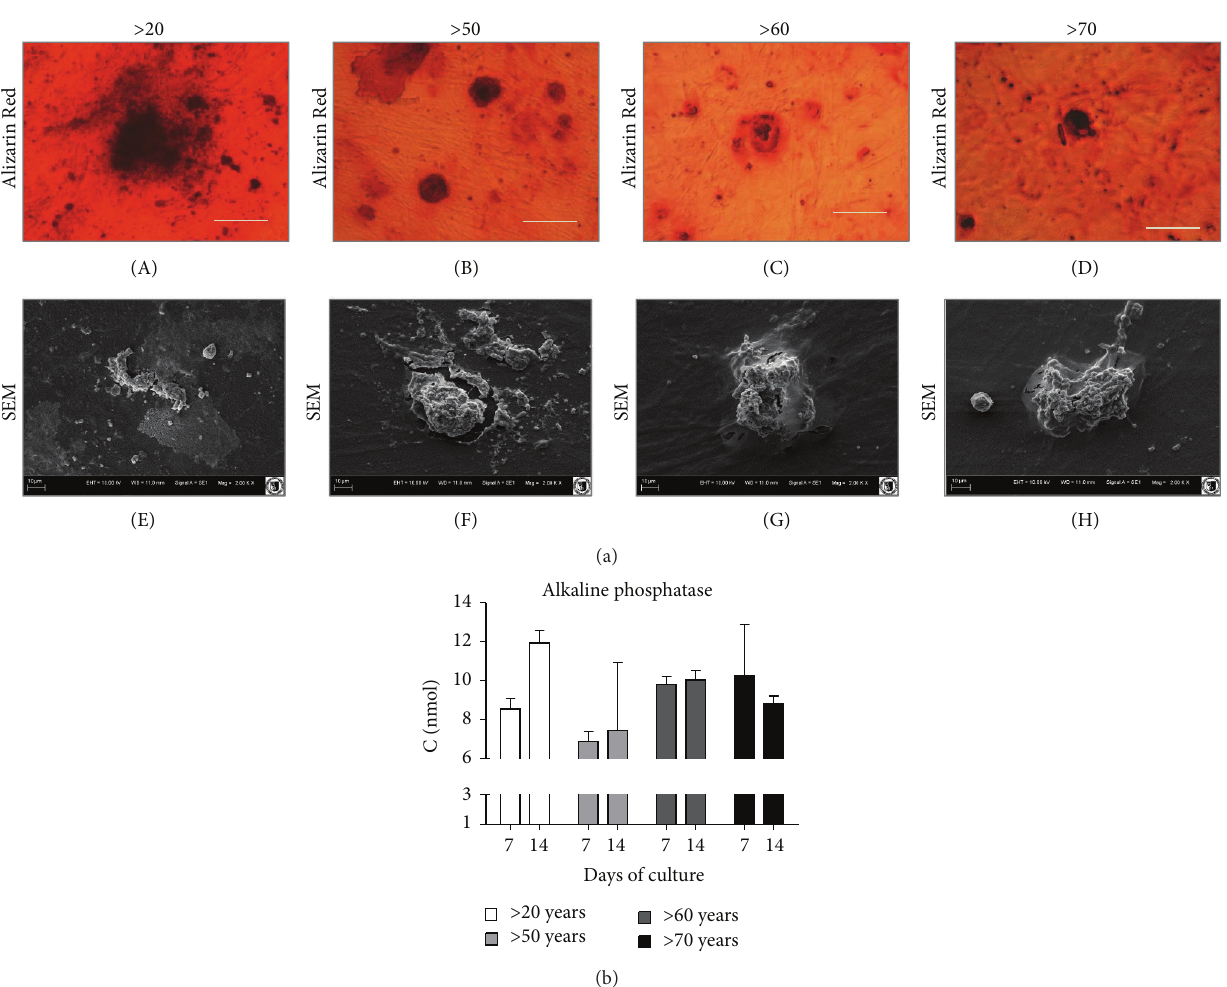
chondrogenic differentiation of human BSMCs. In